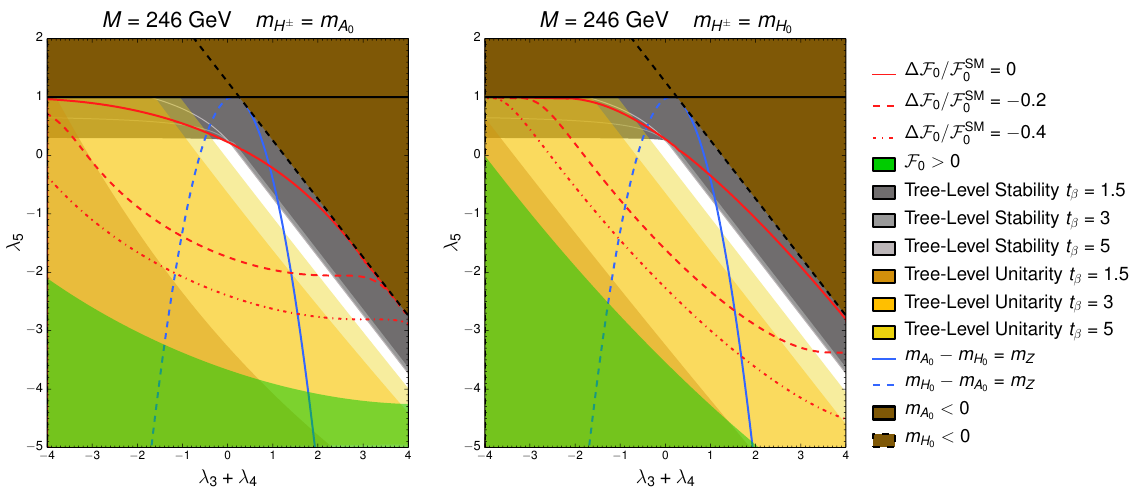
= m A (Left) and m = H (cid:6) H (cid:6) 0 SM = , with the green region corresponding to 0 F 0 F m H > m Z (solid) and m H m A > 0 (cid:0) 0 0 (cid:0) 0